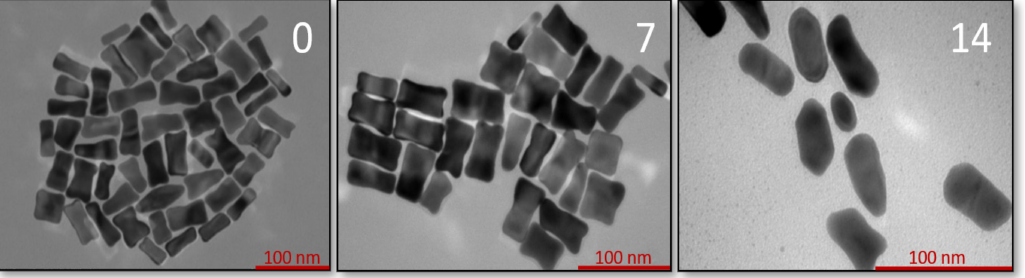
Figure 5. TEM images of GNBs—after synthesis (0), 7, and 14 days of storage at room temperature.